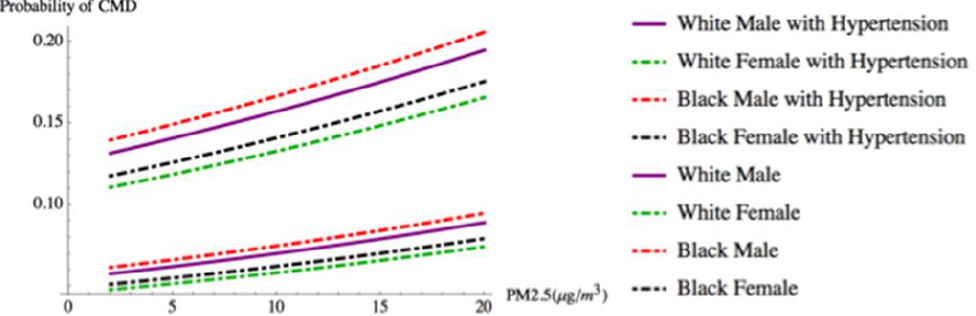
Figure 2. Individuals by race and gender with and without hypertension.